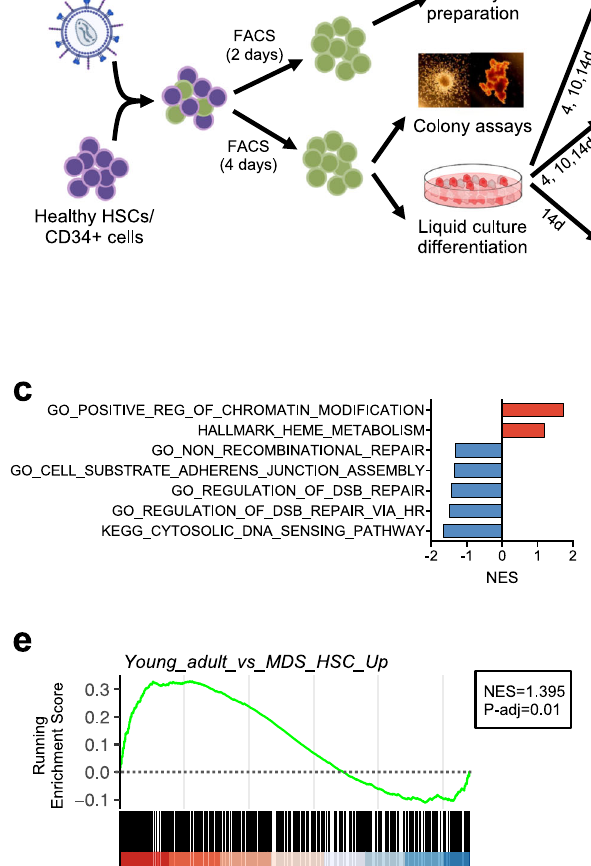
hemoglobin genes and enzymes involved in heme biosynthesis (i.e: PPOX , FECH , ALAS2, HMBS ) showed increased expression during dif- ferentiation in control cells but not in DDIT3 -transduced cells (Figs. 5b